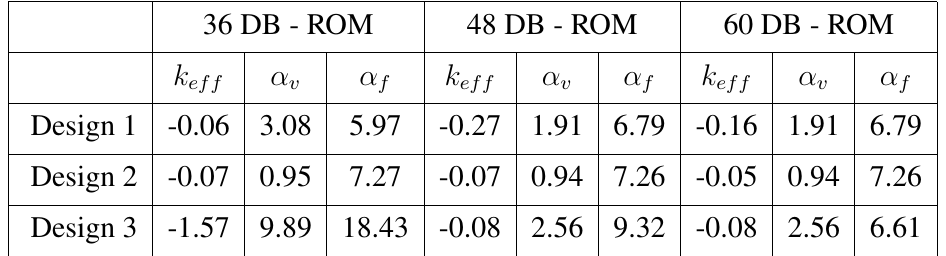
Table 4: Percent Difference in Objective Function between MCNP &